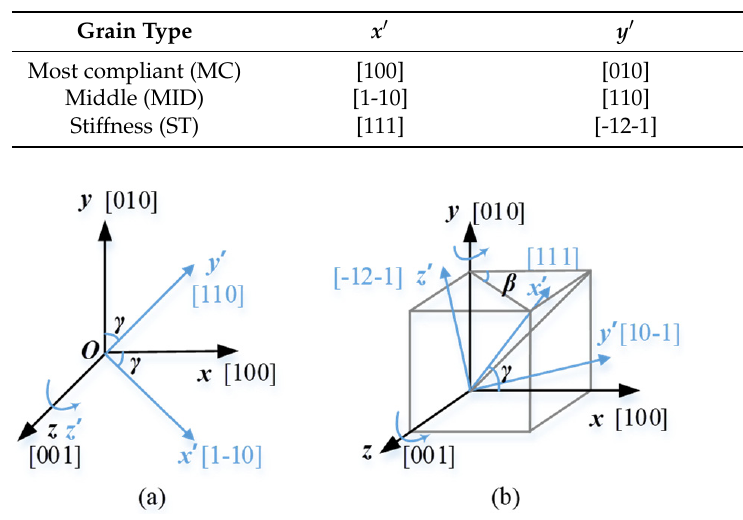
Figure 2. The selected crystallographic direction. Considering the relationship between the [100], [110], and [111] orientations and the stretching axis, three types of crystals with different orientations were modeled [28], as shown in Table 1. The most compliant grain (MC) has the coordinate axes x (cid:48) , y (cid:48) , and z (cid:48) of the local coordinates, which represent the crystal orientations [100], [010], and [001] respectively, and it is consistent with the global coordinate o-xyz. As shown in Figure 3a, the local coordinate of the intermediate stiffness grain (MID) has the (001)-[1-10] direction as the axis x (cid:48) and the (001)-[110] direction as y (cid:48) , by rotating the grain about the [001] direction with angle γ , the MID grain has its local coordinate consistent with the global coordinate. By defining the (111)-[10-1] and (111)-[-12-1] directions as the crystal axes y (cid:48) and z (cid:48) , the stiffness grain (ST) has the [111] direction as the axes x (cid:48) , and the local coordinate of the ST grain will coincide with the global coordinate by rotating the local coordinate about the axis y and z with angle β and γ in sequence. Among the three different grain types, the planes perpendicular to the global coordinate axis x are the (100), (110), and (111) planes in the MC, MID, and ST grains, respectively. Table 1. Crystal orientations considered for grains.